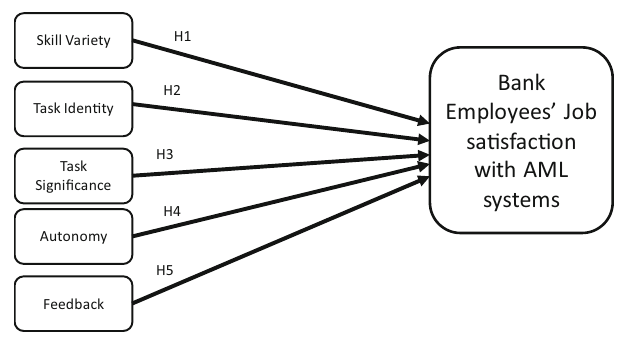
Figure 1. Research